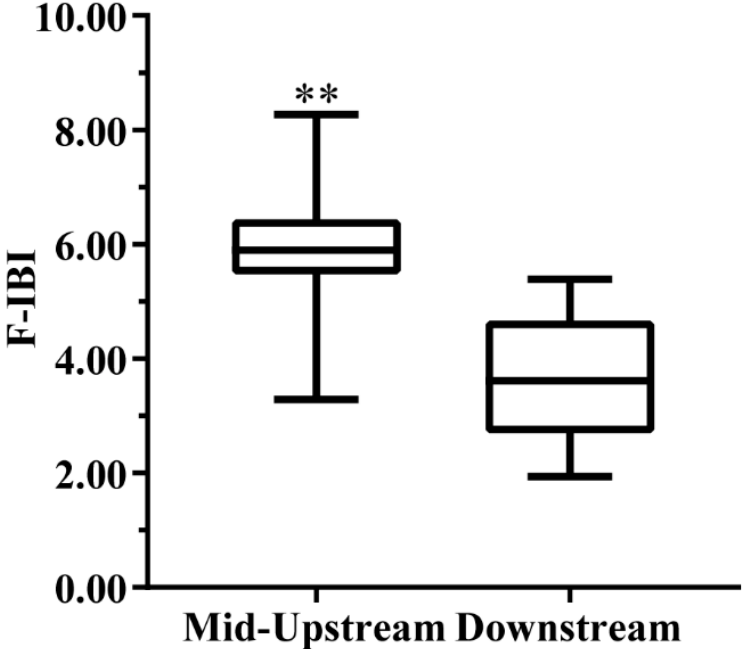
Figure 10. Spatial dynamic box diagram of the aquatic ecological health in the Hun River Basin (**, p <